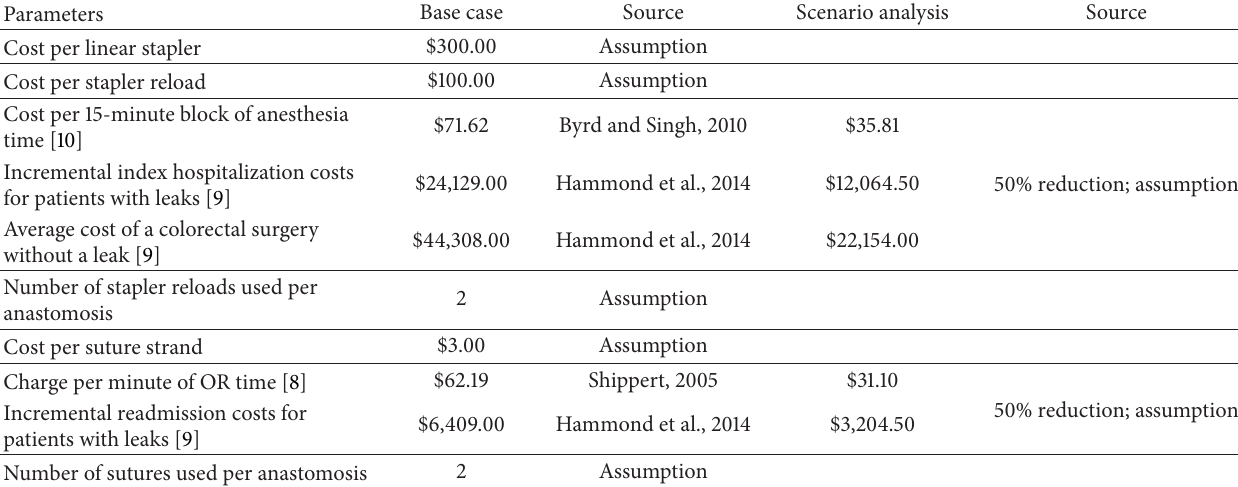
Table 2: Cost inputs included in value analysis